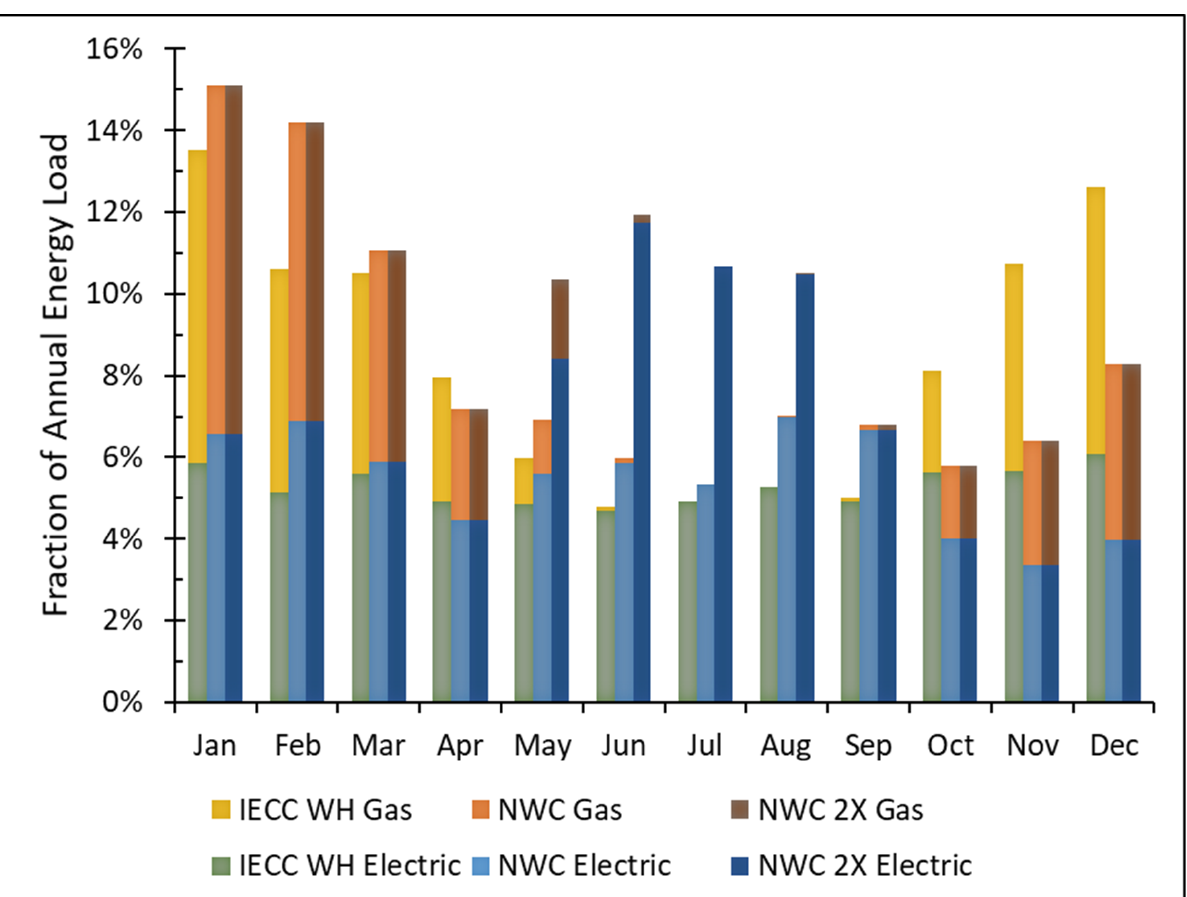
Figure A1. NWC “warehouse” building type annual load distribution profile as modified from IECC Warehouse (WH) model. NWC’s load is characterized by increased winter and summer use, with decreased load in the fall. The electric- natural gas ratio shifts 64–36% IECC to 66–34% NWC. A 2× summer projected load profile results in a 20% total annual load increase (sums to 120%) with a 70–30% electric: natural gas ratio. Table A1. Preliminary NWC Renewable Technology Feasibility Study Results indicating that PV,